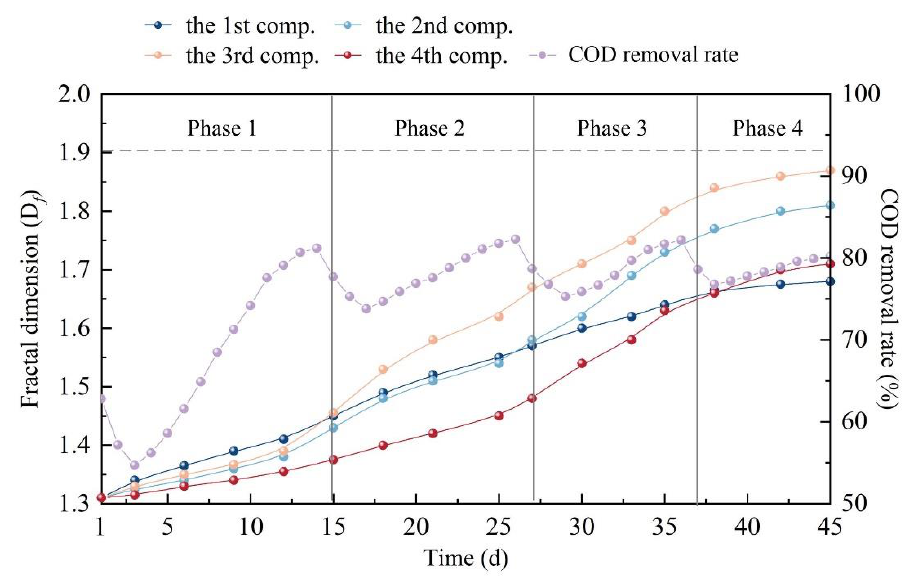
Figure 5. Fractal dimension of the sludge and COD removal rate at each phase during